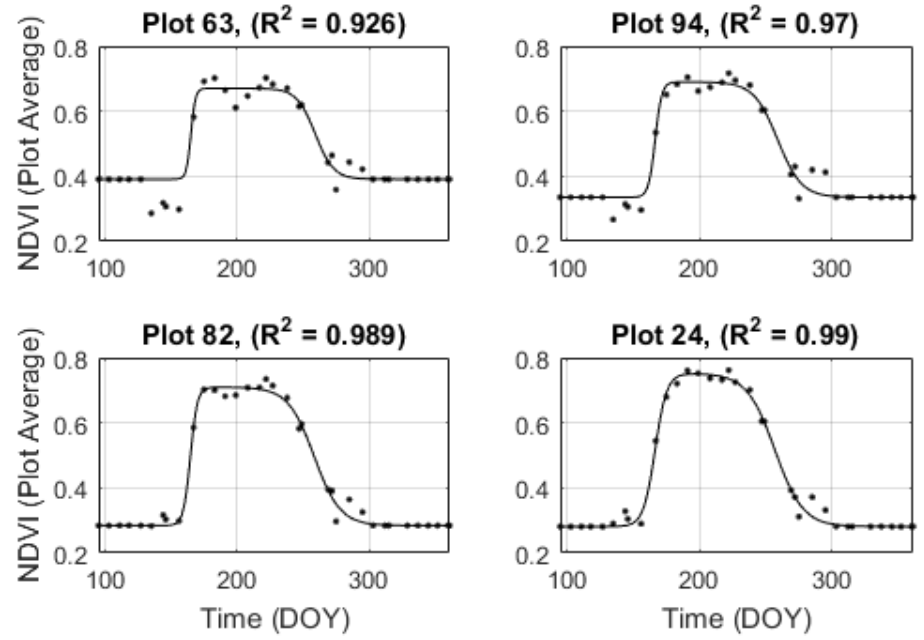
Figure 5. Four different plot-average NDVI time-series resampled to an 8-day average revisit interval and fit to the asymmetric double sigmoid function.